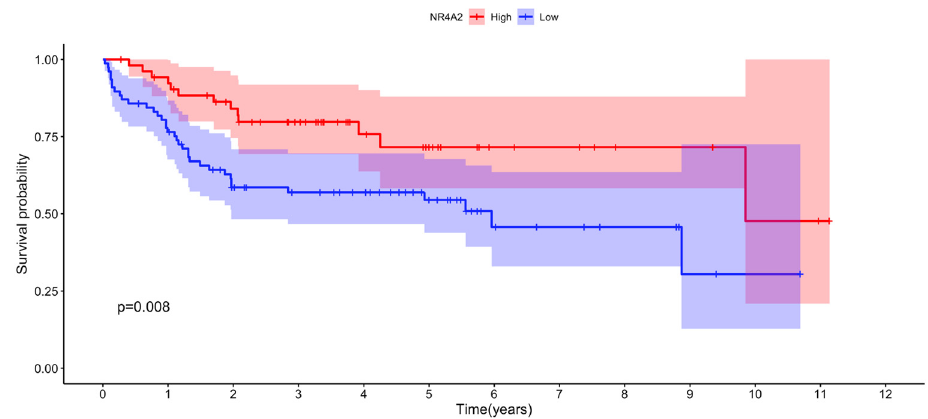
Figure 6. Correlation between NR4A2 expression and overall survival among female ABC DLBCL patients. NR4A2 expression data for each individual female ABC DLBCL and individual survival data were obtained from the EGAD00001003600 data set. Optimal cut point for high vs. low NR4A2 expression was determined using maximally selected rank statistics from the “maxstat” R package. The number of individuals with high and low NR4A2 expression after optimal cut point determination was 55 and 77, respectively. The R packages “survival” and “survminer” were used for the survival analysis. The pink and blue areas show lower 95% to upper 95% CI for low and high NR4A2 expression, respectively. p = 0.008 for the difference in survival between the high and low NR4A2 -expressing individuals.